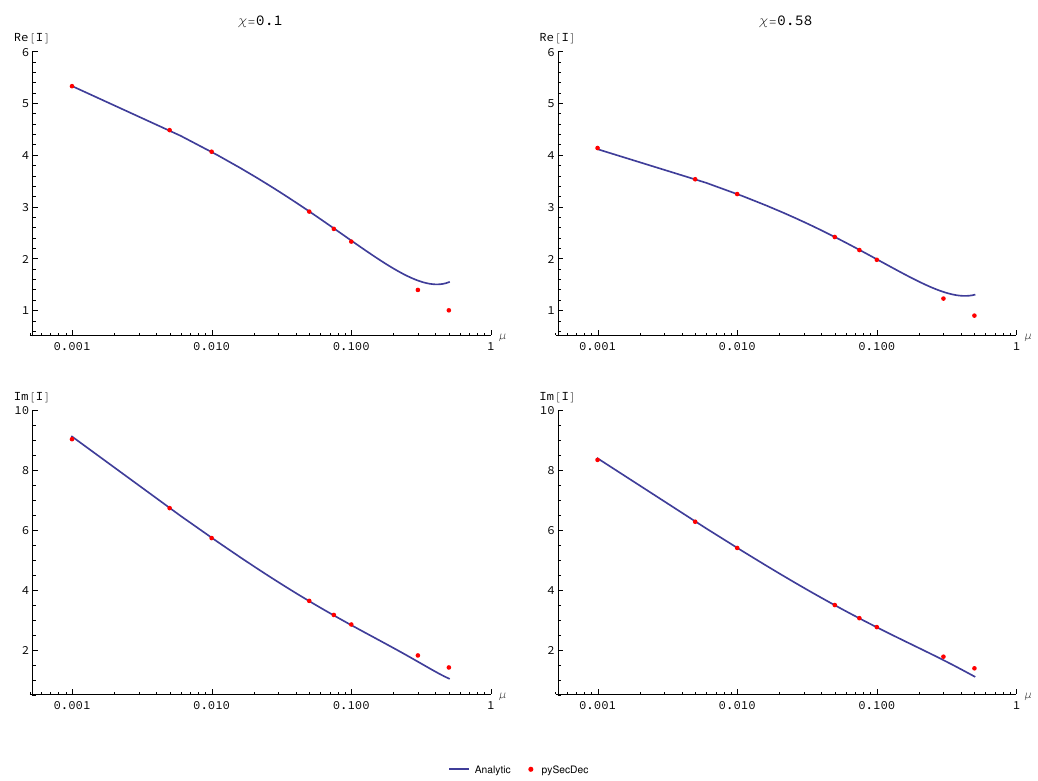
Figure 5 . We compare the real (top row) and imaginary parts (bottom row) of the analytic solution (blue line) against the numerical results (red dots) for a (cid:12)nite integral I np2 kinematic points. The numerical error bands are too small to be